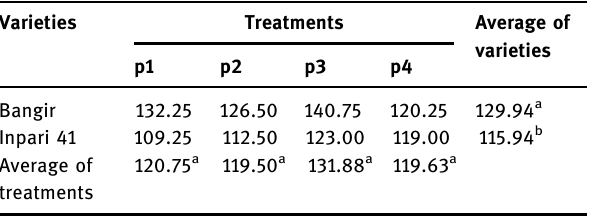
Table 3: Plant height ( cm ) of rice varieties fertilized with di ff erent types of organic manure